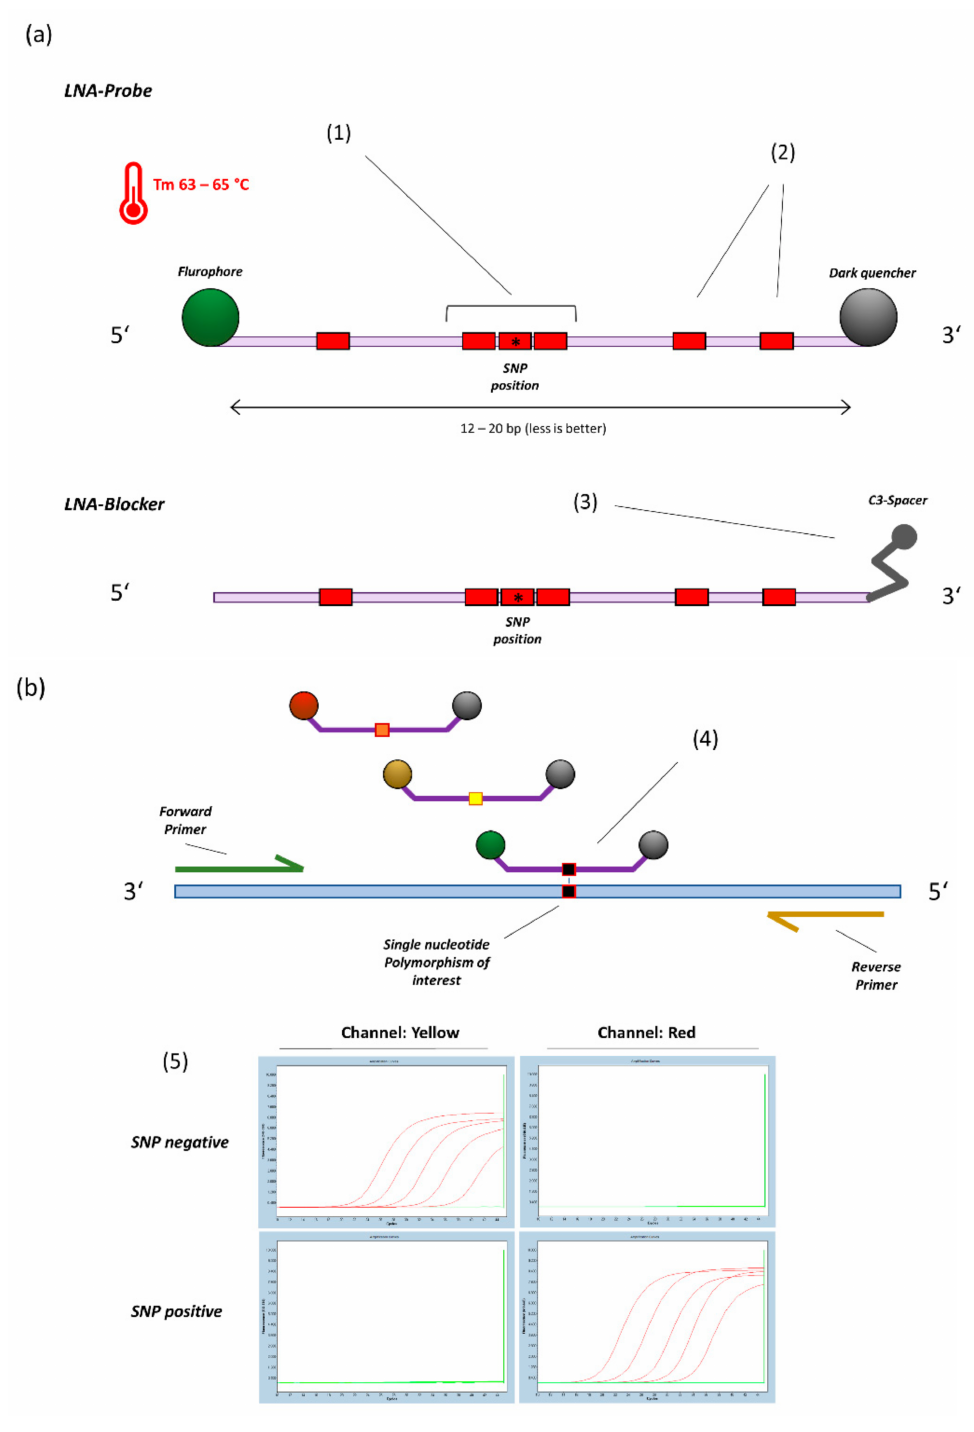
Figure 1. ( a ) General principle of probe design for SNP detection (14). 1. A triplet of LNA bases is centred on the SNP location. 2. Additional LNA-bases are placed based on hairpin and homodimer prediction to achieve a melting temperature of 63–65 ◦ C at a length of 12–20 bases. 3. For target sequences that are not covered by specific probes, a blocker-oligo is created using the same principles but replacing the Fluorophore-Quencher modifications with a 3 (cid:48) C3-Spacer to prevent elongation. ( b ) 4. Multiple SNP specific probes compete for binding at the target sequence. A perfectly matching probe will bind preferentially and generate signal. 5. Example amplification curves on the LightCy- cler480 Instrument (E484K/Q assay). With sufficient optimization, off-target probes will generate virtually no signal, thus providing highly specific dichotomous